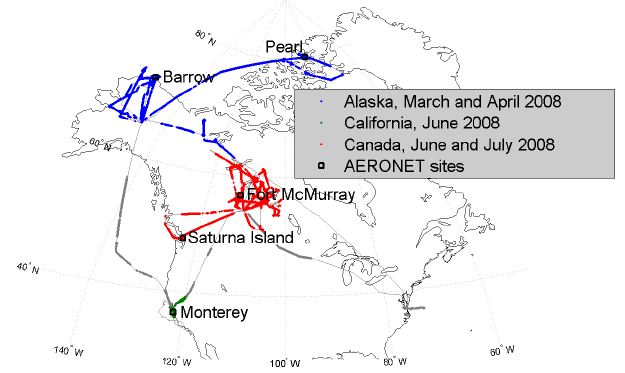
Fig. 1. The flight track of NASA P-3 aircraft during ARCTAS sep- arated into three geographical groups, and AERONET ground sites mentioned in this